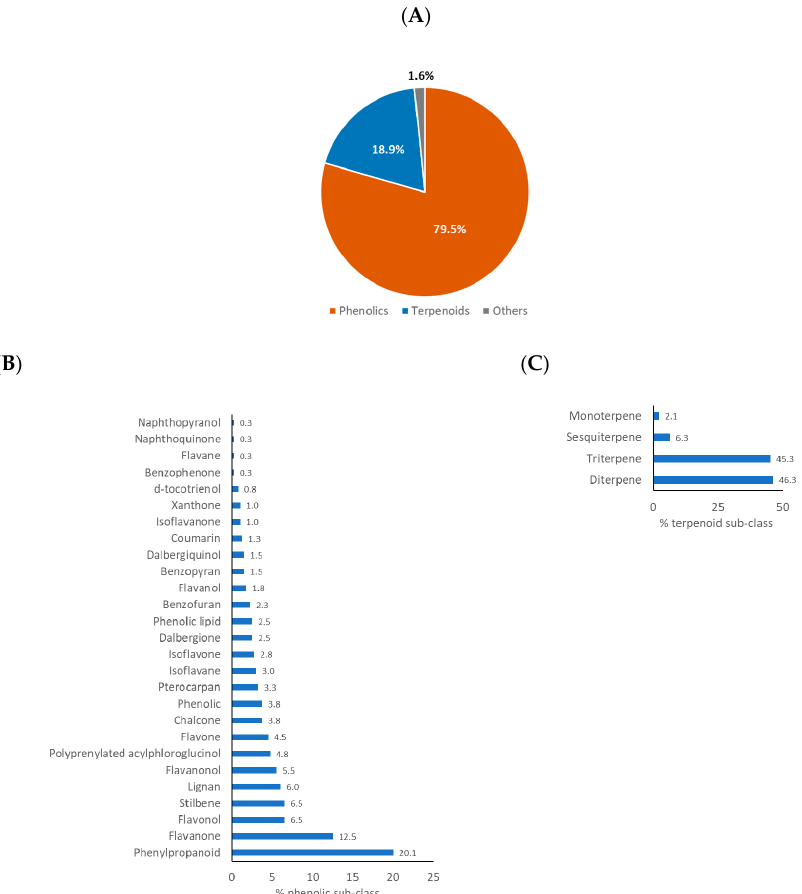
Figure 6. ( A ) Class of compounds isolated from HBP ( n = 502) (phenolics and terpenoids include their glycosides); ( B ) sub-class of phenolics; ( C ) sub-class of terpenoids (overlapped compounds were removed).